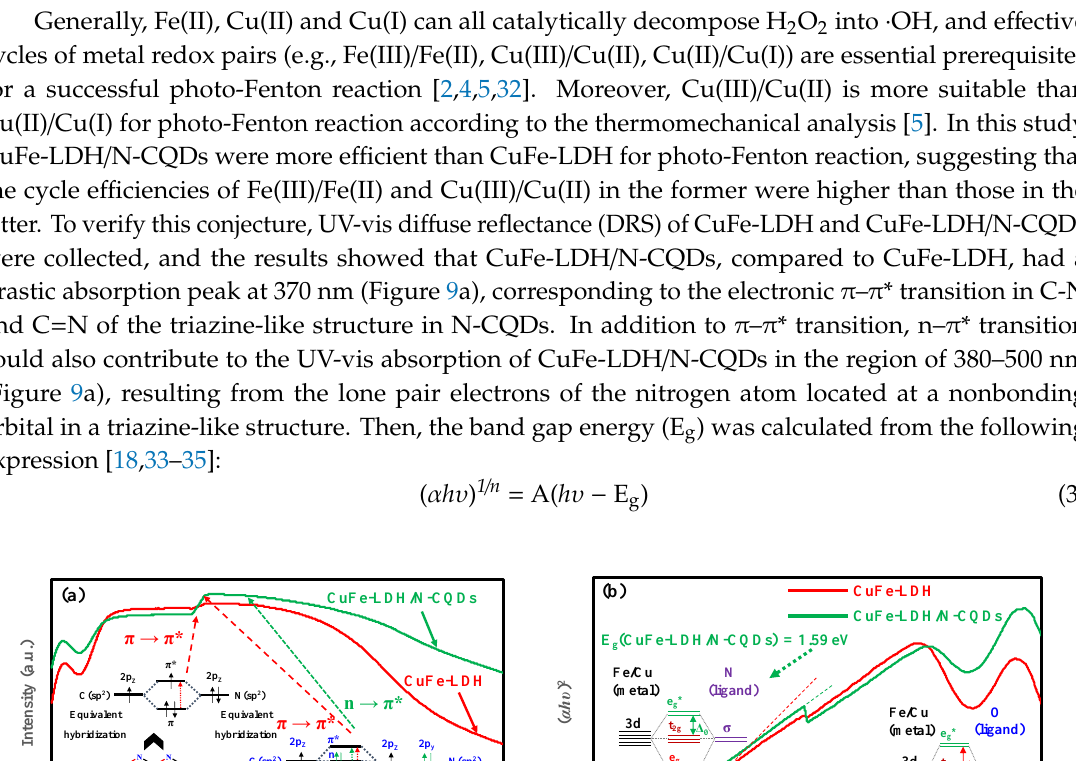
Figure 8. ( a ) Effect of free radical scavengers (TBA and EtOH) on MB removal under simulated solar irradiation and ( b ) pseudo-first-order kinetic fit for MB removal. Error bars represent standard deviation of triplicate runs.